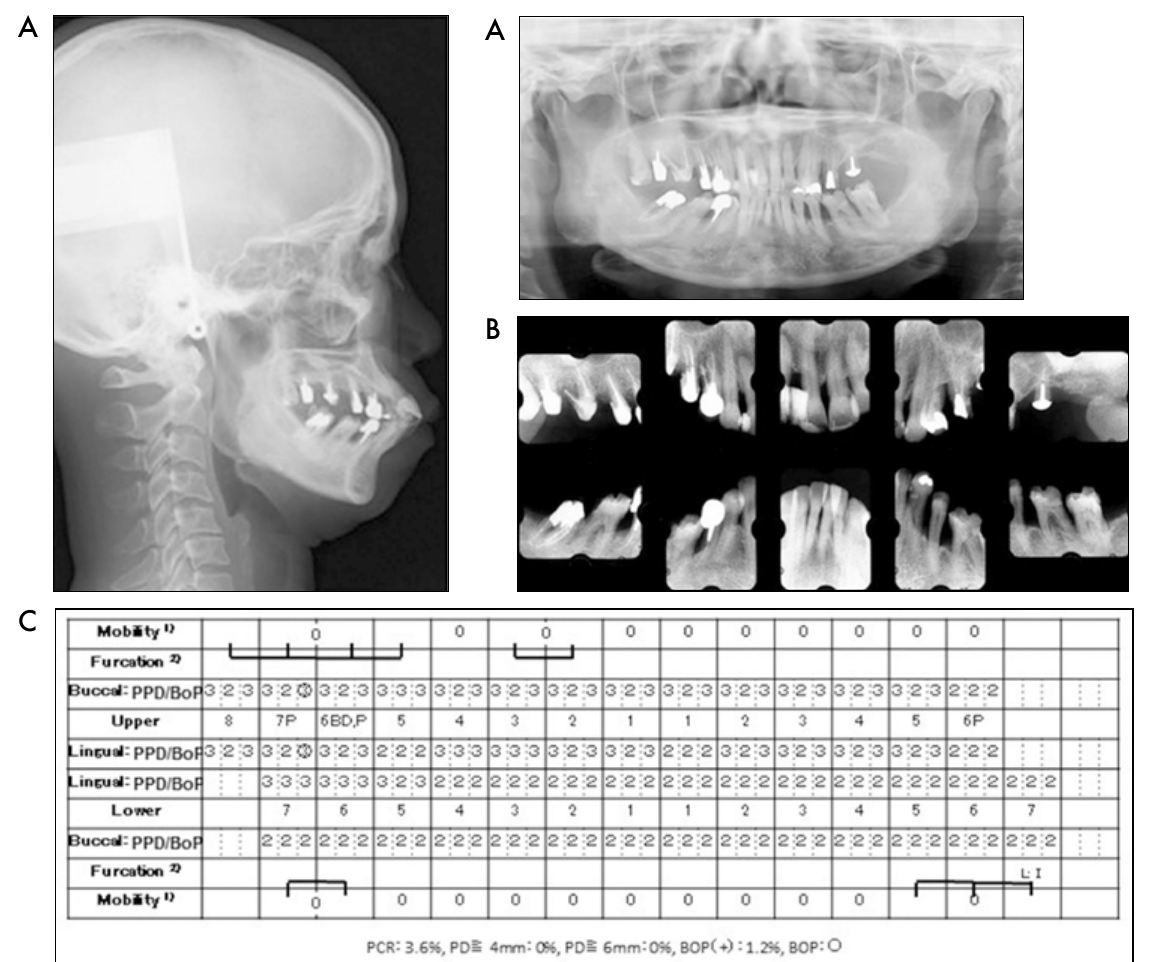
Figure 4. Clinical conditions at the start of the orthodontic treatments. A: Pantomographic and cephalometric X-ray photographs. B: Periapical radiographs. C: Periodontal chart. 1) According to the classification by Miller (1964), 2) According to the classification by Hamp et al. (1975). PPD: Probing Pocket Depth, BoP: Bleeding on